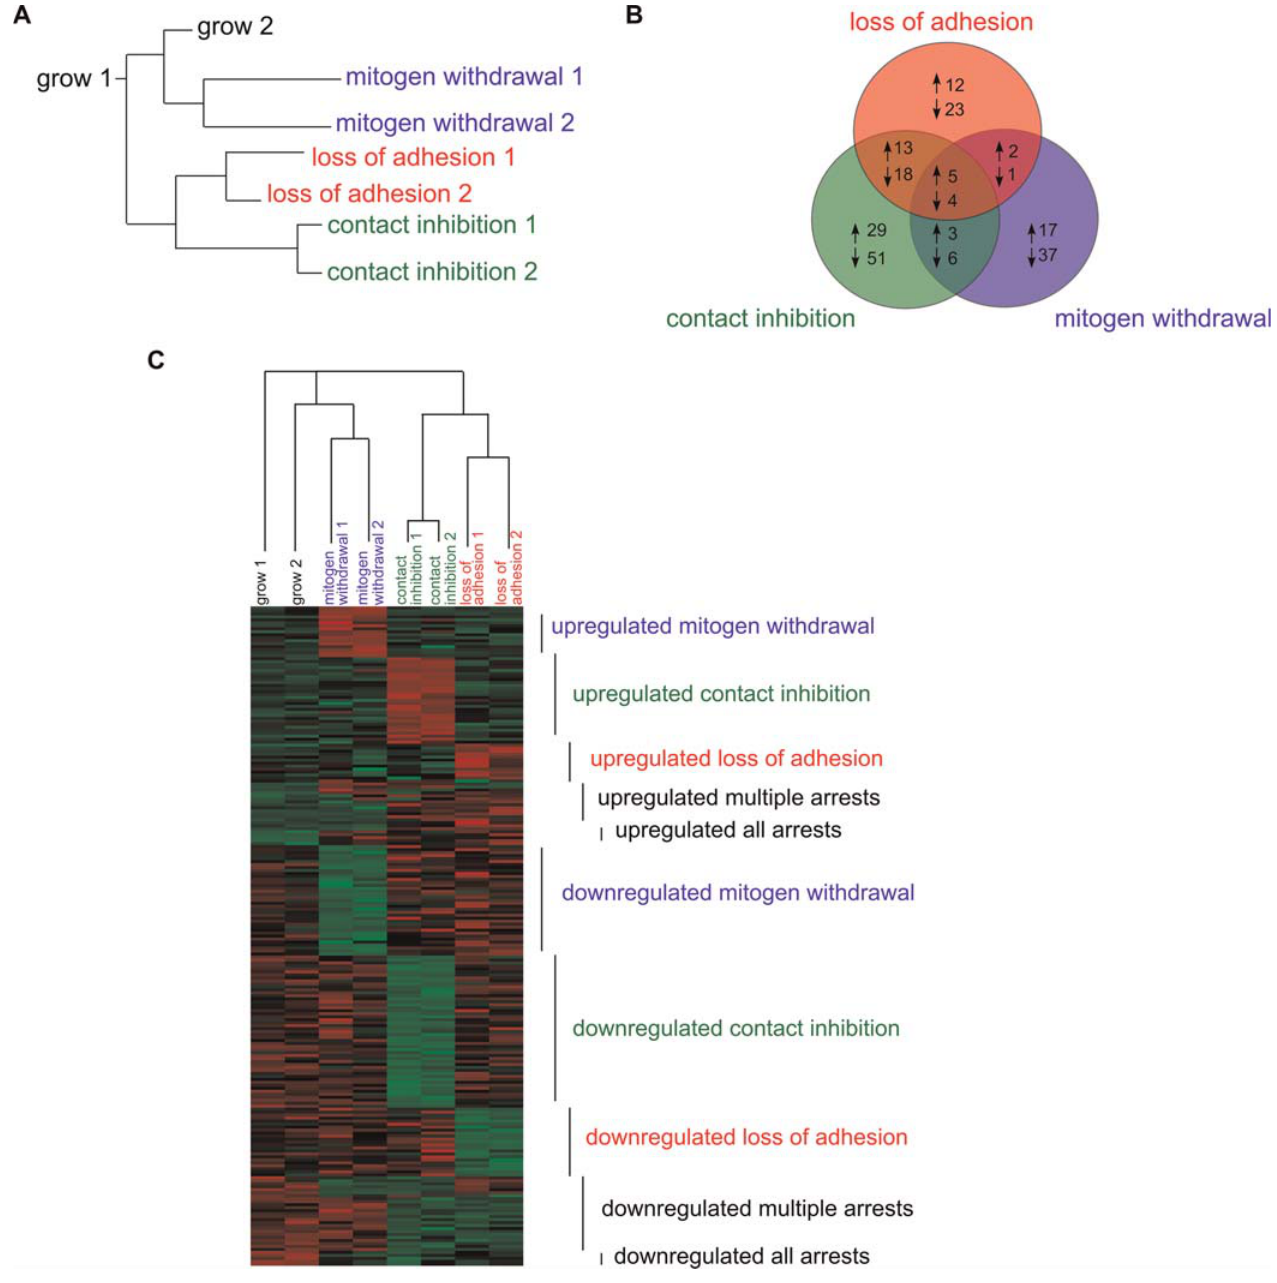
regulation or ‘‘ template-matching. ’’ The number of genes expected to be downregulated by a single signal by chance is 7.8, and the number observed was statistically significant for all three arrest methods ( p , 0.001). The number of genes expected to be upregulated by a single signal by chance is 5.1. The signature for genes upregulated by mitogen withdrawal or contact inhibition alone is significant at p , 0.001, while the signature for genes upregulated by loss of adhesion is significant at p ¼ 0.004. One gene was expected to be downregulated by two out of three signals by chance. For mitogen withdrawal combined with contact inhibition, and loss of adhesion combined with contact inhibition, the observed number of downregulated genes was statistically significantly higher than expectation ( p , 0.001). For mitogen withdrawal combined with loss of adhesion, the result was not statistically significant. The expected number of genes upregulated by two arrest signals is 0.75. For genes upregulated by mitogen withdrawal combined with contact inhibition, and by loss of adhesion combined with contact inhibition, the number of regulated genes is significant ( p , 0.001). For mitogen withdrawal combined with loss of adhesion, the result was not statistically significant. The number of genes expected to be downregulated by all three signals was 0.85, and the observation of four was significant at p ¼ 0.009. The number of genes expected to be upregulated by all three arrest signals is 1.2, and the observation of five is significant at p ¼ 0.006. (C) ‘‘ Heat maps ’’ of genes regulated during quiescence initiation. Samples of growing cells and cells arrested by a single signal for 14 h were flow sorted and analyzed with microarrays. Genes regulated by one, two, or all three signals were identified both by consistent 2-fold change and by ‘‘ template- matching ’’ as described in Materials and Methods. Genes are represented by rows; columns indicate samples. The average difference values for each gene were normalized. The relative expression levels for a gene among the samples are indicated by green for a low value and by red for a high value. The figure was generated with Java Treeview [54]. The dendrogram above the figure depicts the topology of a neighbor-joining tree generated from the transcriptional distances between each sample. The complete tree is shown in (A). DOI: 10.1371/journal.pbio.0040083.g002 PLoS Biology |